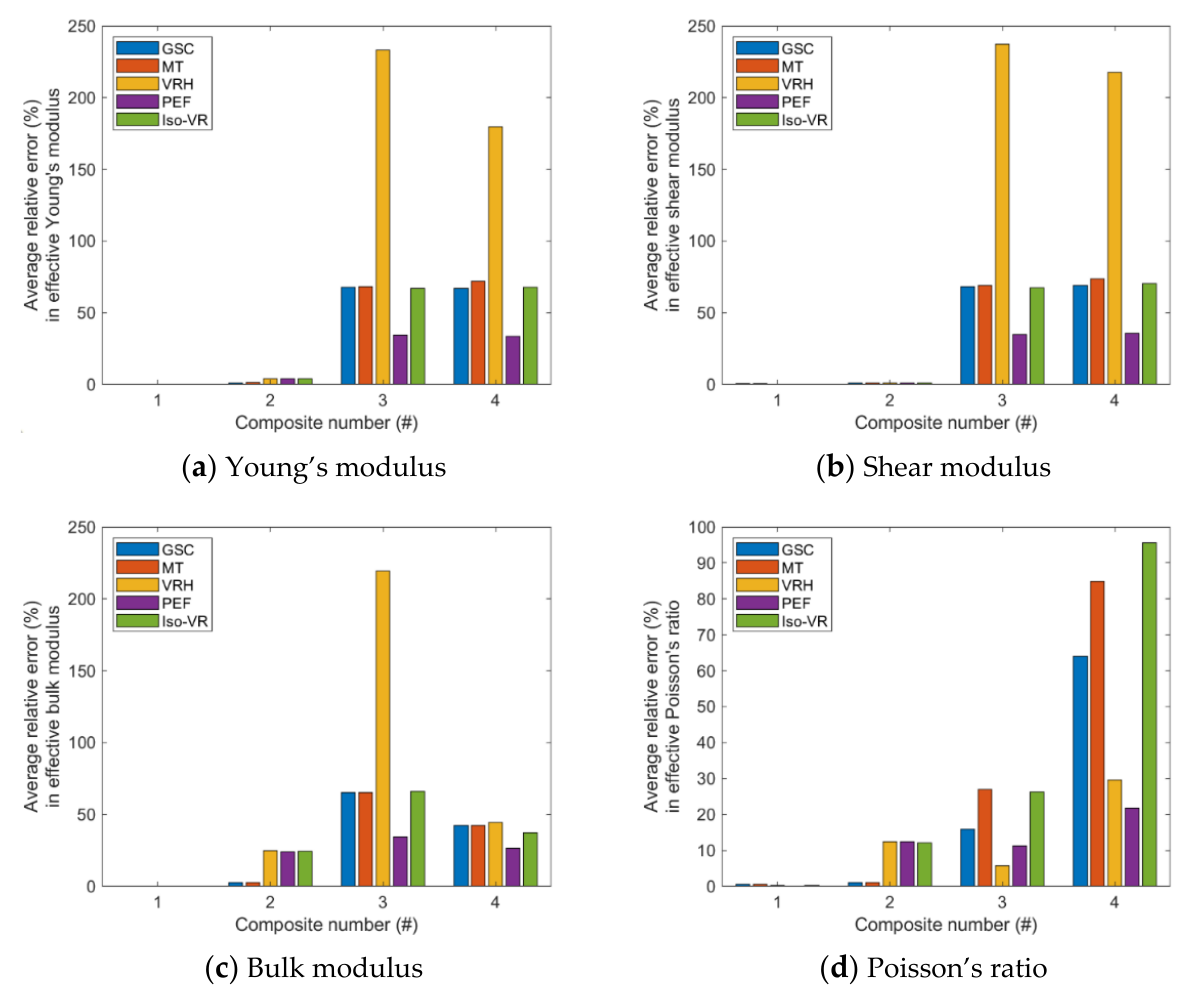
Figure 2. The average relative errors in the effective elastic properties .